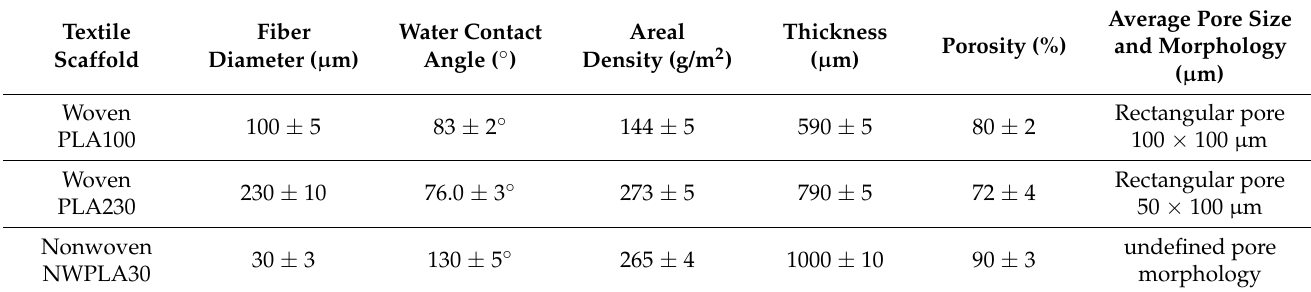
Table 1. Properties of PLA scaffolds (wovens and